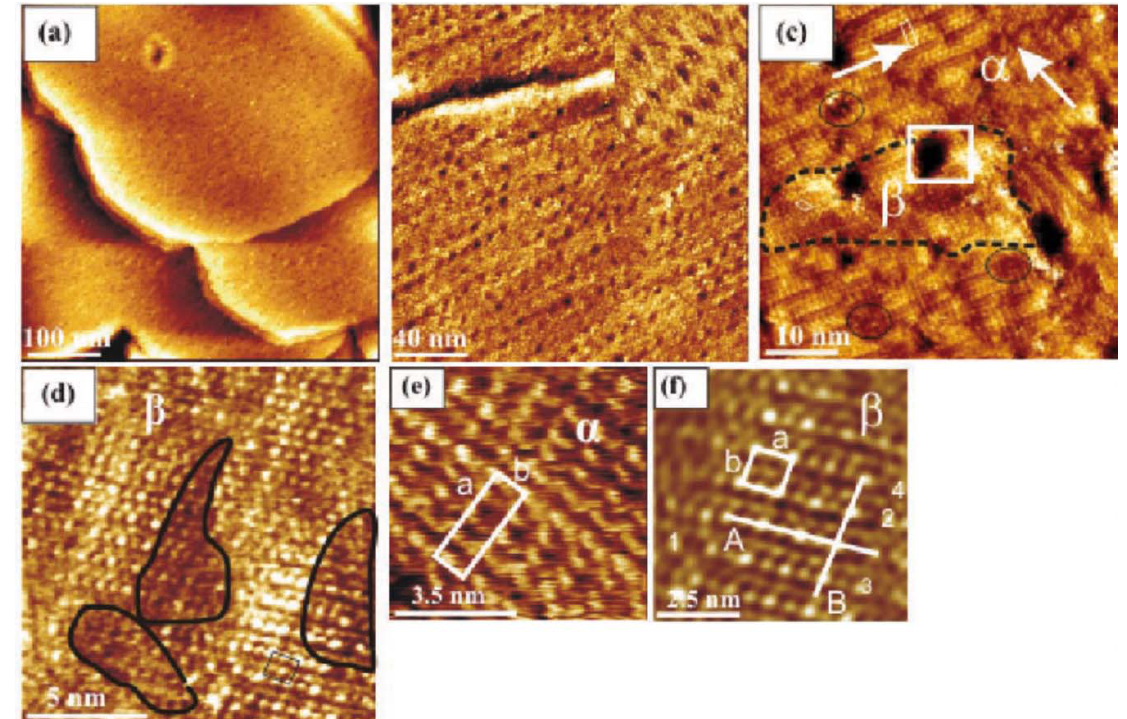
Figure 1. Constant-current images for a Au(111)-substrate, which has been immersed for 2 h into 100 μM solution of BP2 in ethanol RT. The unit cell of the rectangular (5 √ 3×3) structure is marked in (c) and (e). The unit cell of the rectangular (2 √ 3×3) structure is marked by the rectangular in (d) and (f). Tunneling parameters: (a) U= 1000 mV; I= 148 pA, (b) U= 850 mV; I= 148 pA, (c) U= 550 mV; I= 148 pA, (d) U= 550 mV; I= 130 pA, (e) U= 530 mV; I= 148 pA, and (f) U= 530 mV; I= 148